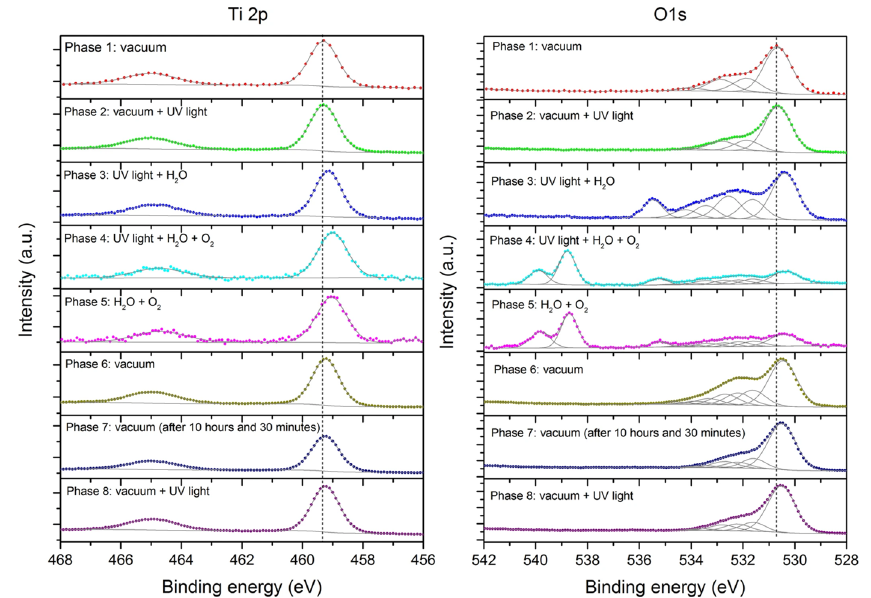
Figure 7. X-ray photoelectron Ti 2p and O 1s spectra of TiO 2 exposed and unexposed step-wise to UV light, water, and oxygen. Phase 5 shows the presence of peroxides and dissolved H 2 O 2 indicative of residual catalysis. Reprinted from ref. [228]. Copyright 2017, the author(s). Published by Springer